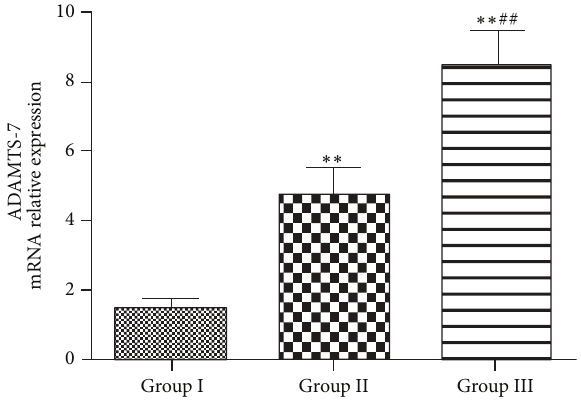
Figure 3: ADAMTS-7 mRNA expression in femur articular carti- lage samples of each group: statistically significant increases in the mRNA expression of ADAMTS-7 were observed in group II and group III compared with group I ( ∗ 𝑃 < 0.05 , ∗∗ 𝑃 < 0.01 ). A significant increase in the mRNA expression was observed in group III compared with group II ( # 𝑃 < 0.05 , ## 𝑃 < 0.01